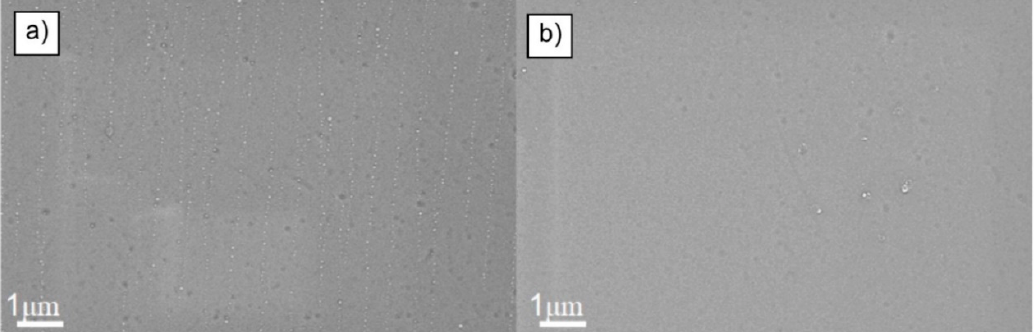
Figure 14. ( a ) Planar SEM and ( b ) cross-sectional STEM images show the hydrophobic coating A, with the presence of nanoparticles on the coating surface. Note that the gold film is deposited on the surface to prevent charging during SEM imaging.